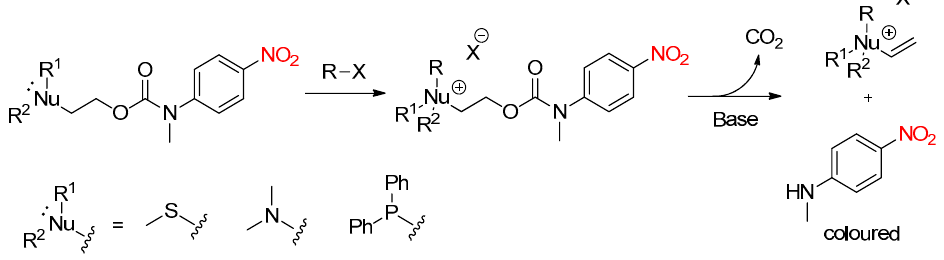
Scheme 27. Proposed self-immolative mechanism using electrophiles.